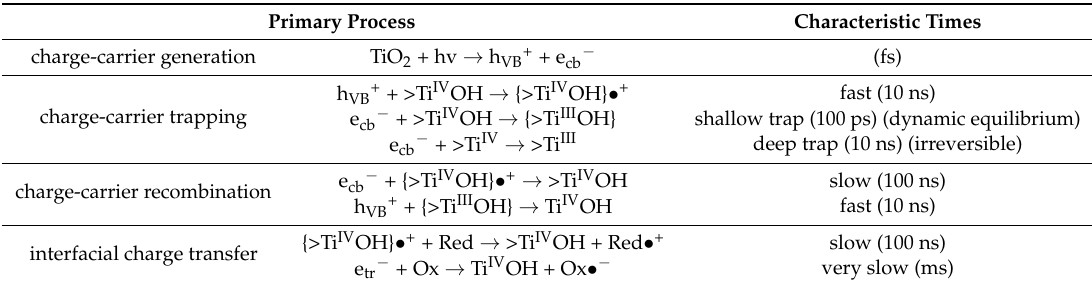
Table 1. Mechanism for heterogeneous photocatalysis on TiO 2